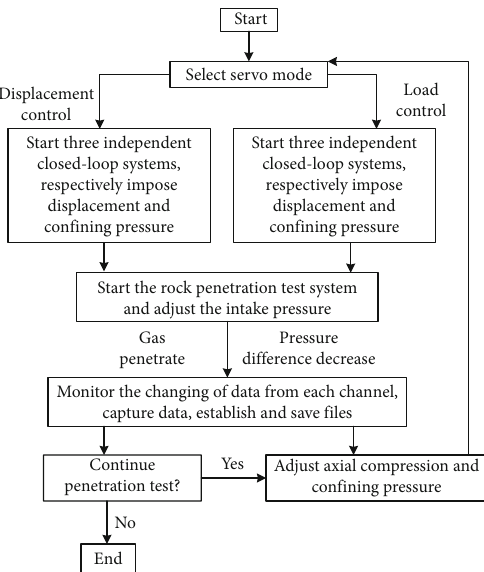
Figure 7: Control fl ow chart of permeability test under unloading con fi ning pressure.